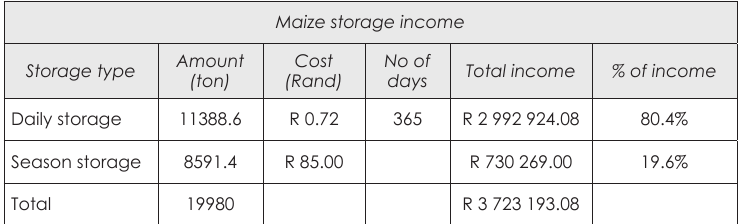
Table 5: Income from storing